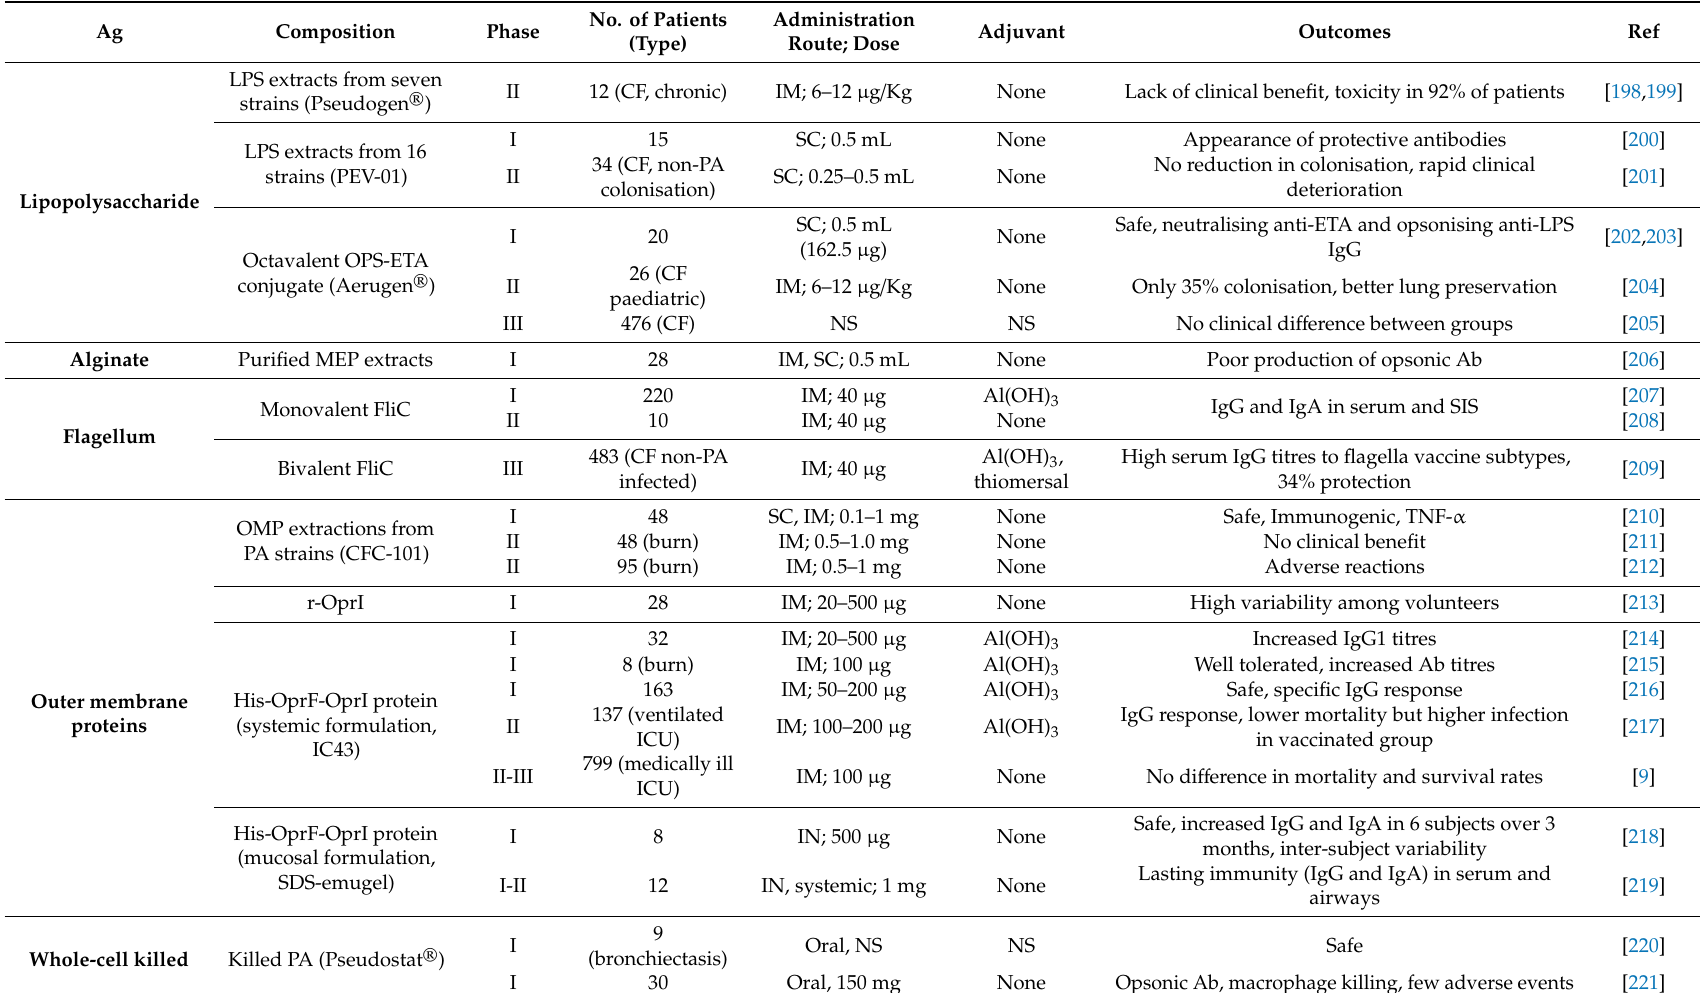
Table 2. Summary of clinical studies on P. aeruginosa vaccine candidates